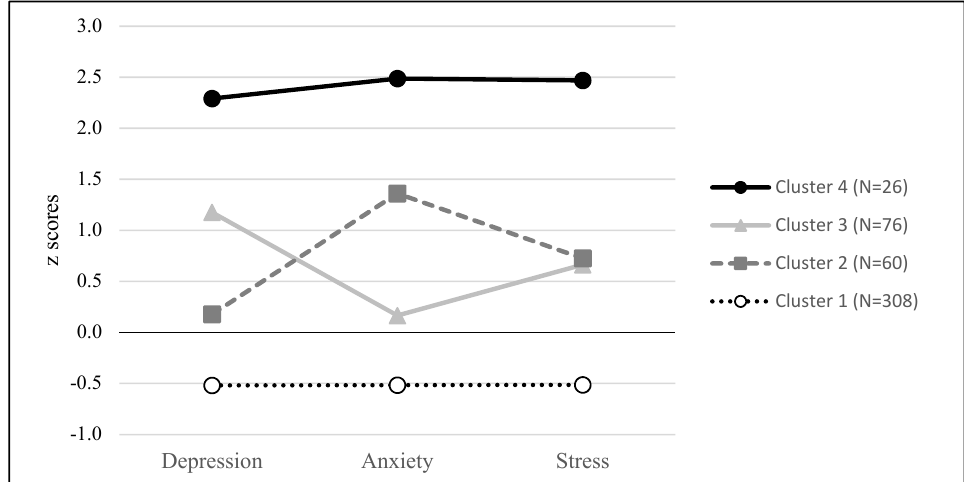
Figure 1. Final cluster among teachers.